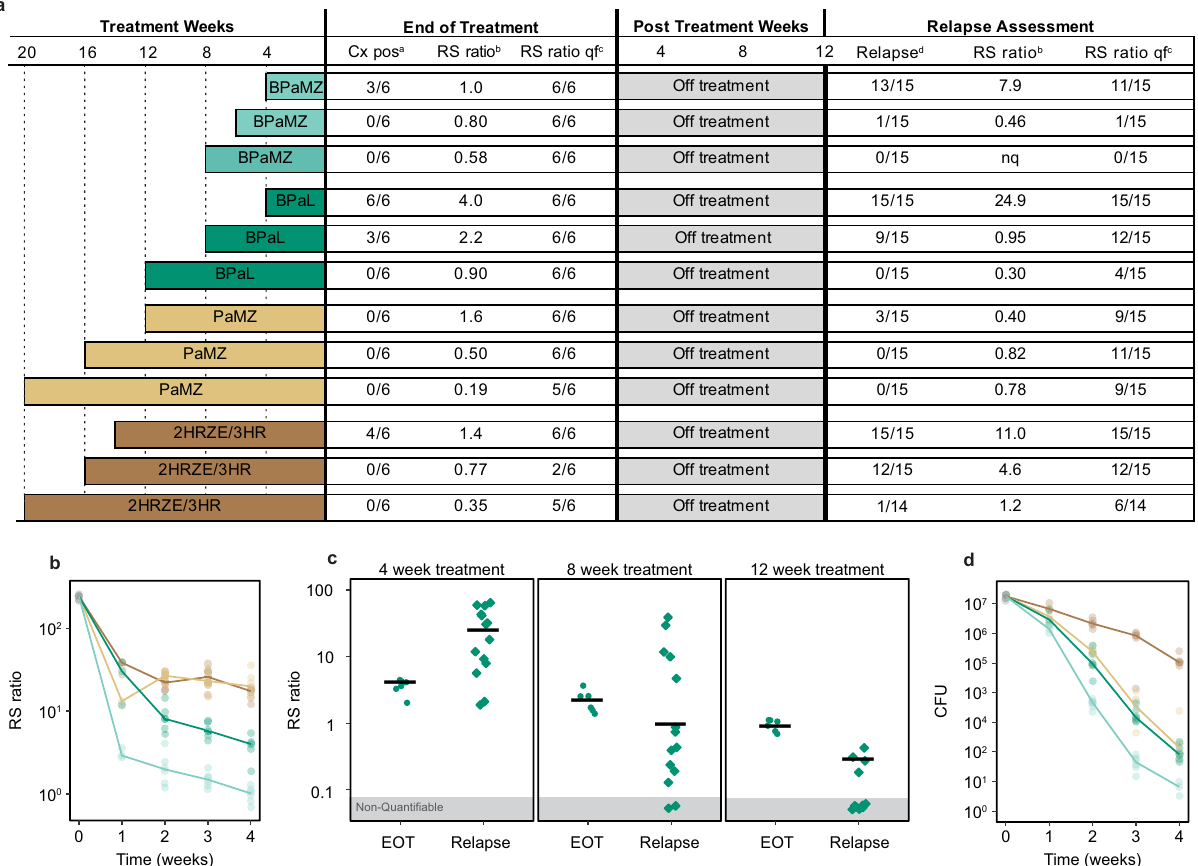
Fig. 5 RS ratio correlated with the sterilizing potency of four regimens in the conventional relapsing mouse model. a Summary of treatment durations and outcomes at the end of treatment and the time of relapse assessment in the BALB/c mouse relapse model. At the end of treatment, the numbers of mice with growth of Mtb in culture and with quanti fi able RS ratios are shown. The median RS ratio for each treatment is shown. At the time of relapse assessment, the numbers of mice with microbiologic relapse and with quanti fi able RS ratios are shown. The median RS ratio for each treatment is shown. b RS ratio during treatment weeks 1 – 4 in lung homogenate from mice treated with BPaMZ (light green), BPaL (dark green), PaMZ, (light brown), or HRZE (dark brown). Circles represent values from individual mice ( N = 3 per regimen at week 1 and N = 6 per regimen at weeks 2, 3, and 4). Solid lines connect median values. c RS ratio results following 4, 8, and 12 weeks of treatment with BPaL. Circles represent individual mice ( N = 6 per regimen and duration) at end of treatment (EOT). Squares represent mice at the time of relapse determination ( N = 15 per regimen and duration) after a 12-week drug holiday. d CFU per lung at the same timepoints in the same mice as in b with the same number of mice represented in the same color